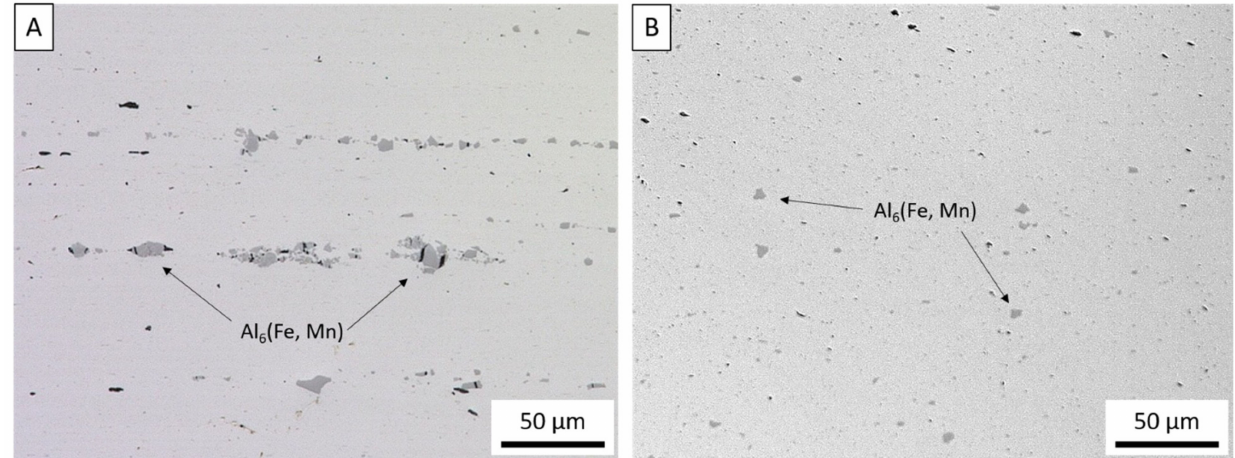
Figure 3. ( A ). Optical micrograph of wrought AA5083-H131 plate showing constitutive particles pancaked between the rolled grains. ( B ) Optical micrograph of as-deposited AA5083 after AFS-D showing smaller, dispersed constitutive